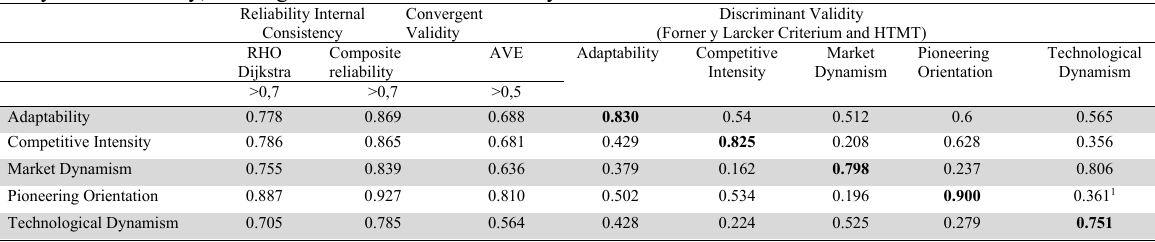
Analysis of reliability, convergent and discriminant validity of the constructs Reliability Internal